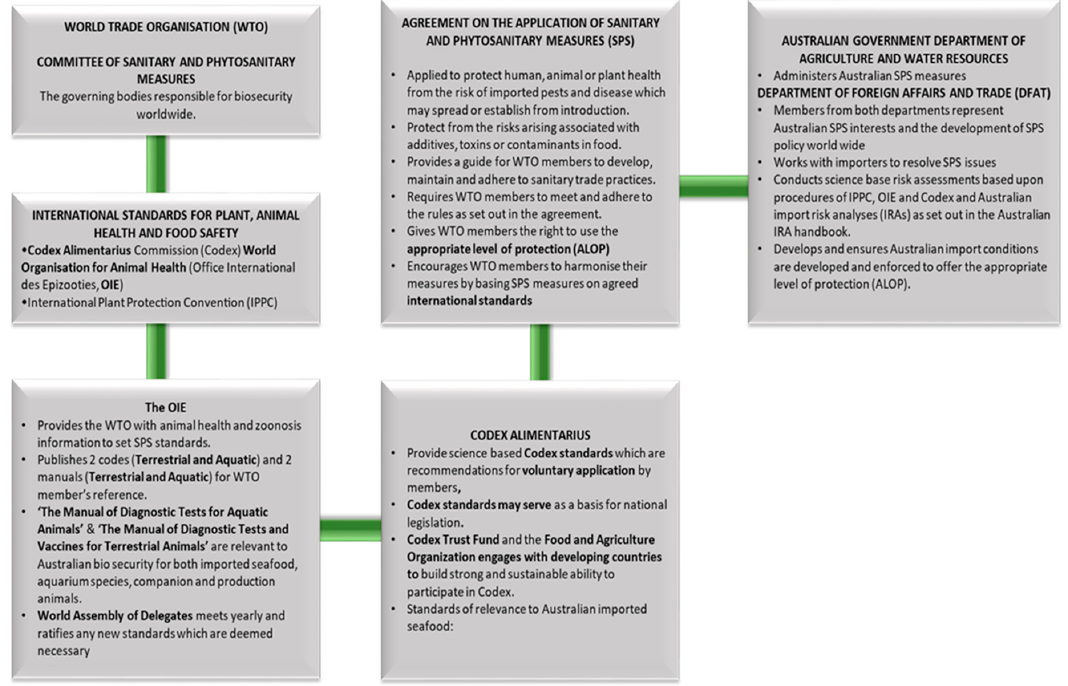
Figure 2. The global processes which relate to the safety of edible seafood on arrival into Australia.